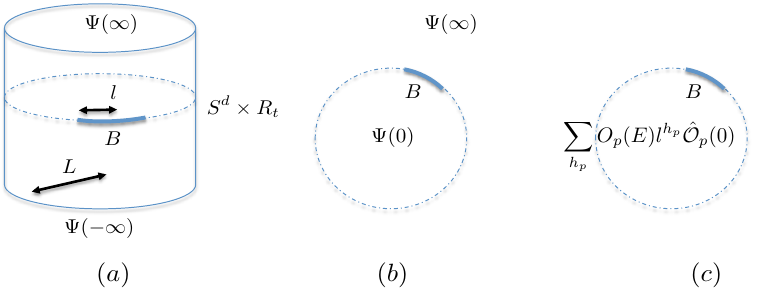
R Figure 1 . (a) The cylinder S d t frame and the Euclidean path-integral that prepares the density (cid:2) matrix in the eigenstate corresponding to (cid:9) on subsystem B (b) The same path-integral in the radial quantization R d +1 conformal frame (c) The path-integral for ETH in the radial quantization frame. 2 = 2 primary states e i(cid:11)(cid:30) (cid:10) with large dimension h (cid:11) = (cid:11) 1. The OPE coe(cid:14)cient of this j i j j (cid:29) heavy state with a primary of dimension one, @(cid:30) , explicitly violates (1.6) since it grows